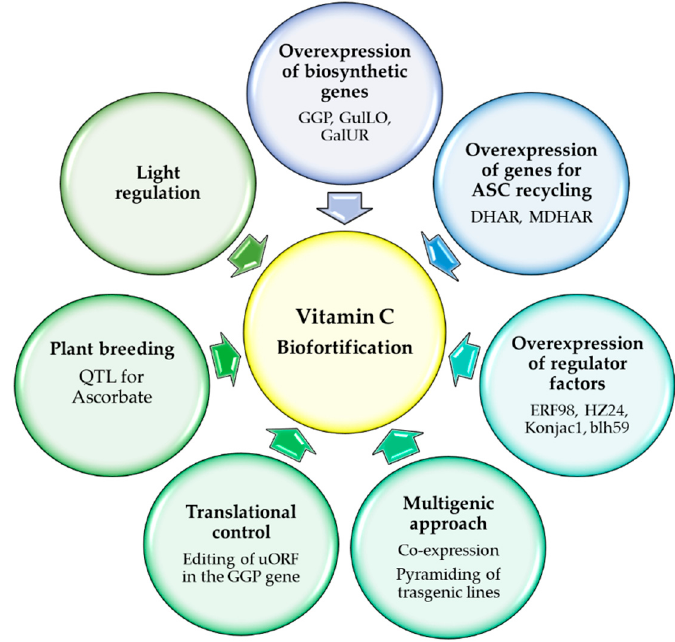
Figure 4. Strategies for vitamin C biofortification. Modulation of light intensity and quality can be used to obtain vitamin C enrichment in crops. The overexpression of single or multiple genes belonging to the biosynthetic and recycling pathways, as well as to the regulatory network, represents a good tool for vitamin C biofortification. Vitamin C accumulation can be controlled by modulating translation by the editing of the uORF in the GGP gene. Finally, vitamin C biofortification can be obtained by plant breeding that exploits candidate genes in the quantitative trait locus (QTL) associated with high vitamin C content (more details are provided in the